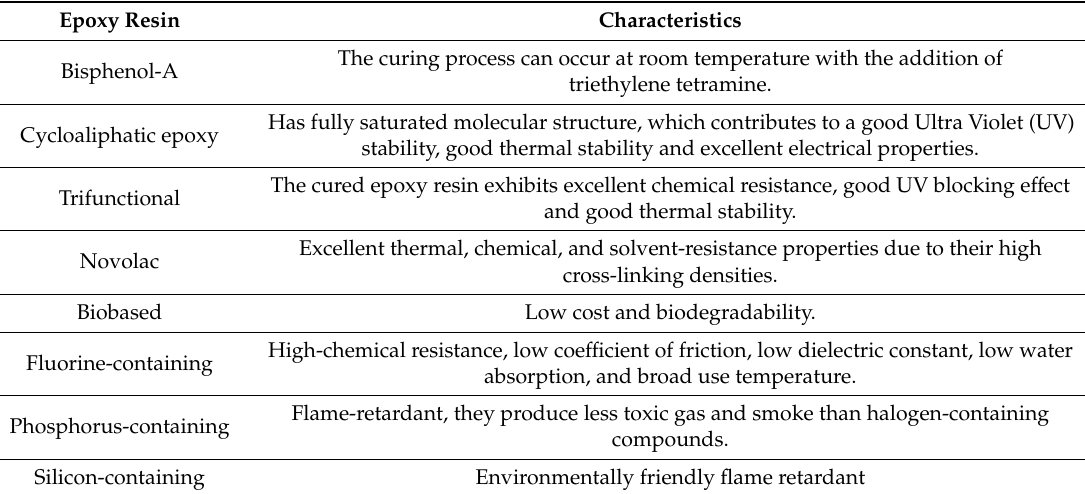
Table 1. Epoxy resins for industrial applications